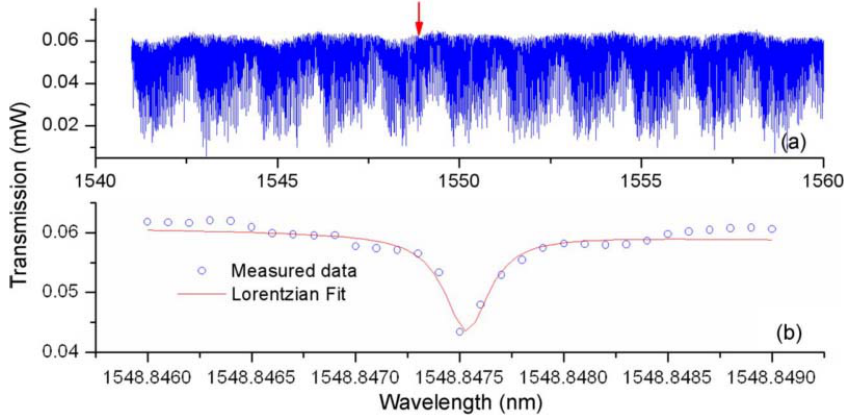
Figure 18. ( a ) Transmission spectra of the bismuth glass microsphere; ( b ) close-up spectrum range from 1548.846 ‐ 1548.849. Reprinted/Adapted with permission from [74].